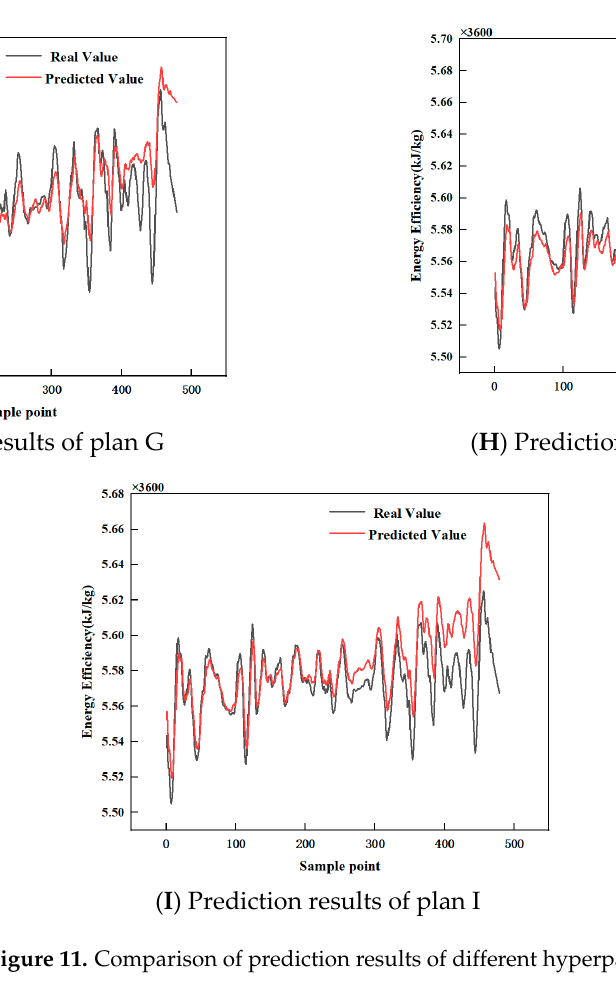
Table 12. The evaluation criterion of the orthogonal test.